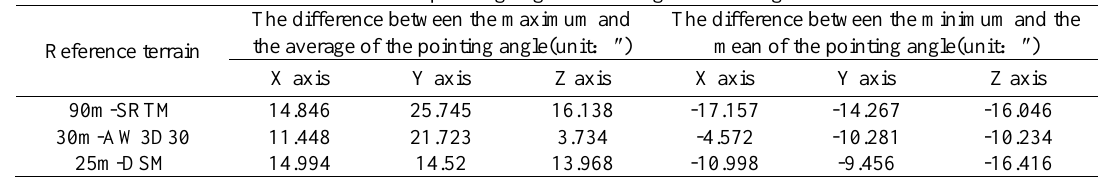
Table 5. The difference between pointing angle and average value using same reference terrain